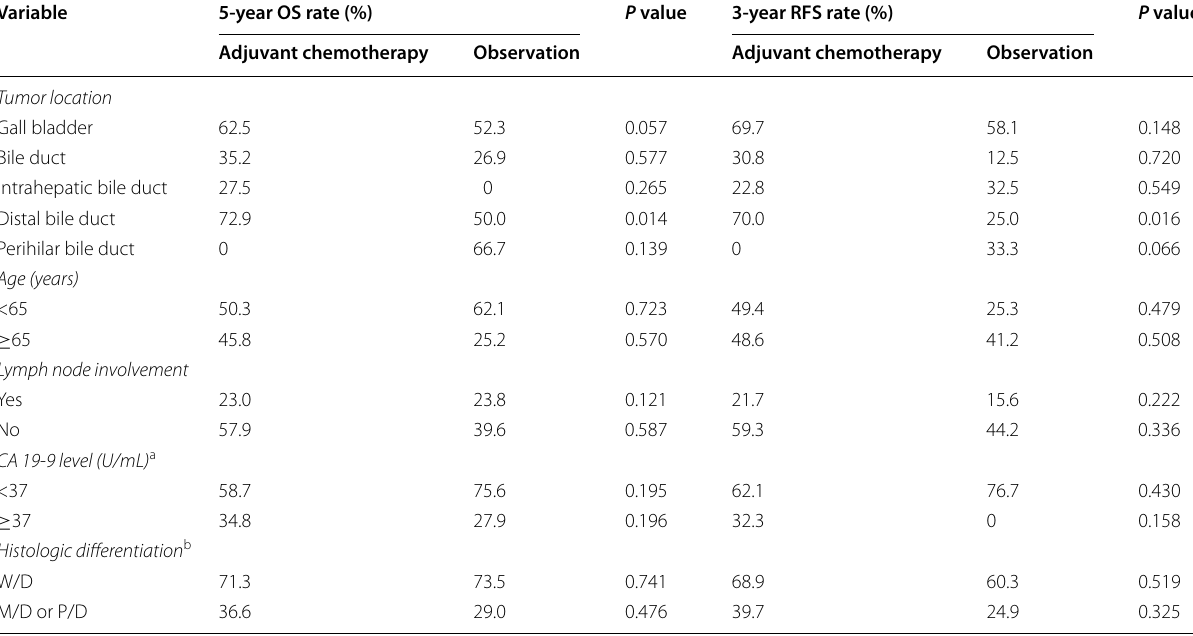
Table 3 Subgroup analysis of survival between two groups of BTC patients undergoing R0 resection